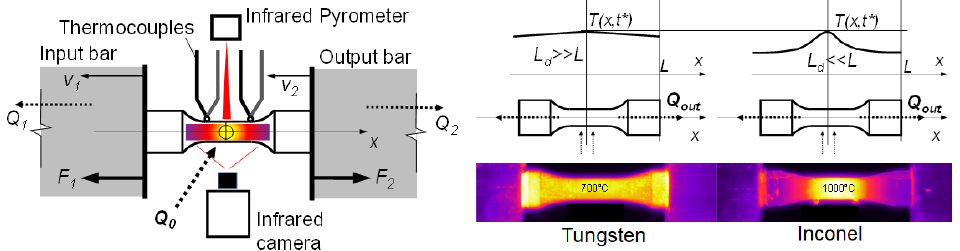
Figure 6. Scheme of the temperature control systems adopted in dynamic high temperature tests ( left ); comparison between heating obtained on pure tungsten and Inconel 718 cylindrical dog-bone specimens with the same dimension by imposing the same heating power ( right ).